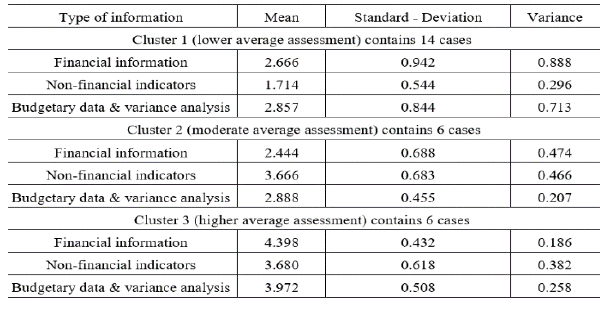
Table 3: The assessed suitability of selected management accounting information in Poland